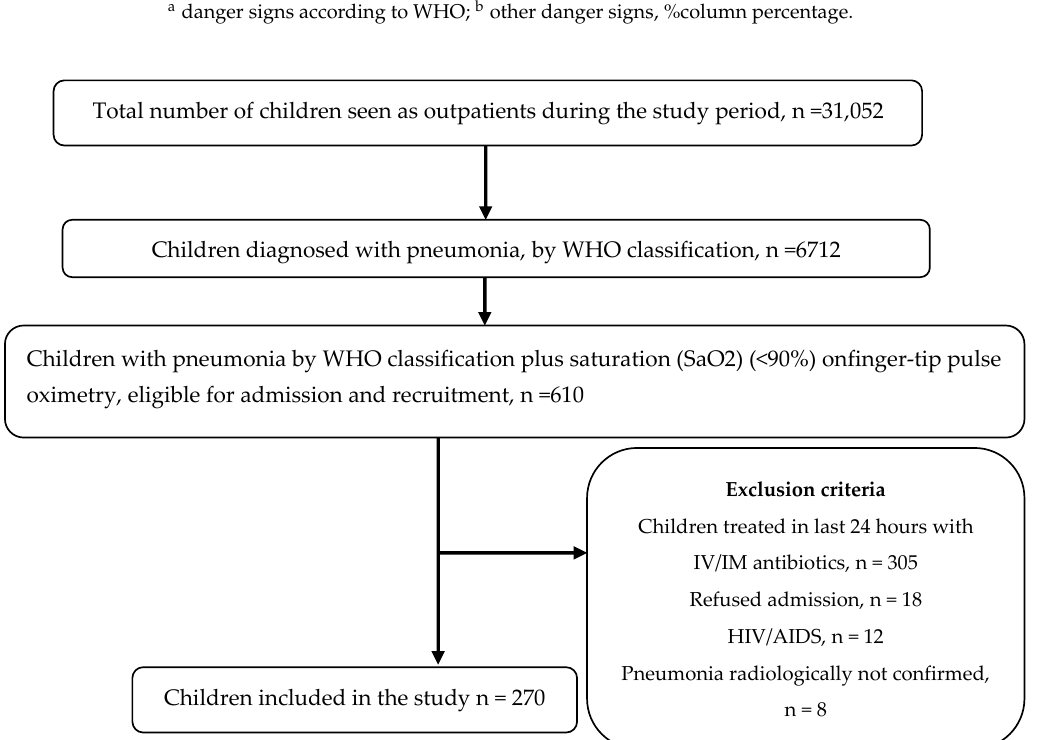
Total number of children seen as outpatients during the study period, n =31,052